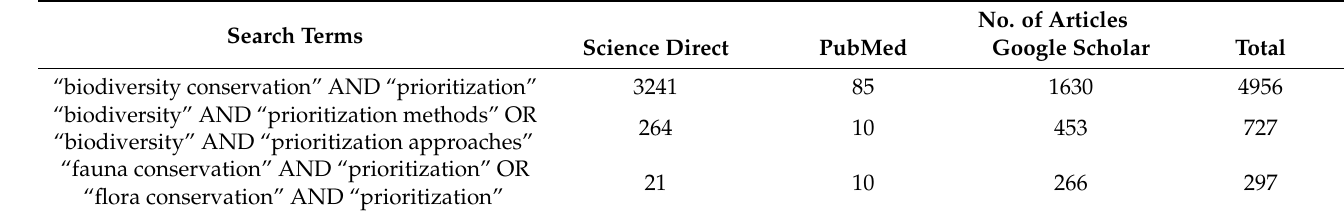
Table 1. The search terms entered in ScienceDirect, PubMed, and Google Scholar databases for the data collection of the present systematic literature